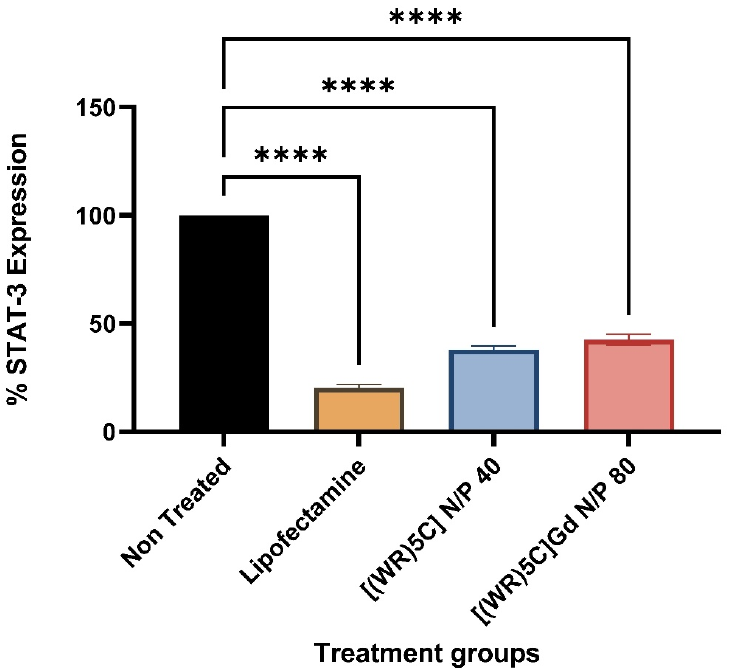
Figure 8. Quantification of % STAT-3 expression from the gel electrophoresis experiment in MDA- MB-231 cells.; ( n = 3), bars represent the standard deviation (if p < 0.0001 then ****).